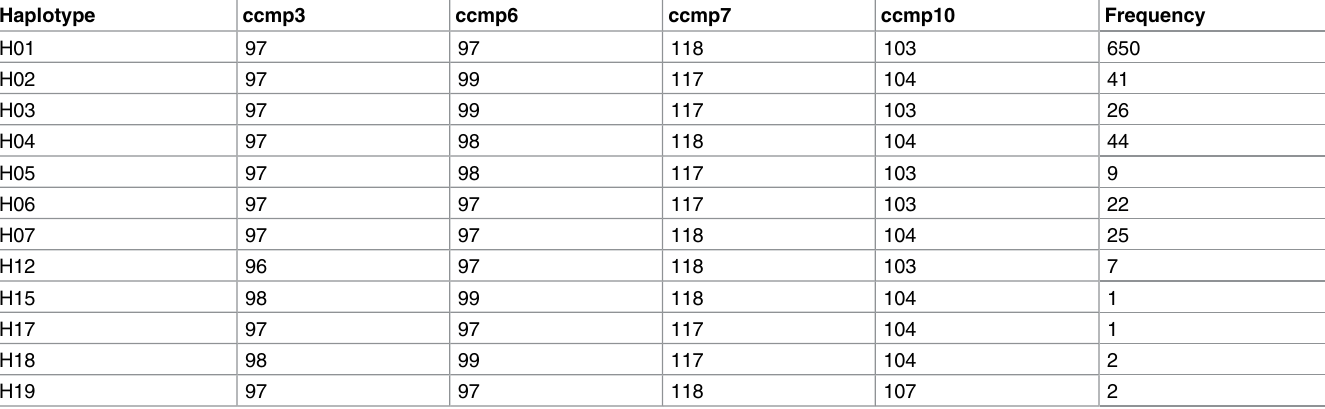
Table 1. Characteristics of the plastid DNA haplotypes detected for Fraxinus excelsior in this study using four chloroplast microsatellite regions. The haplotypedefinitionsfollow Heuertz et al . [41] and Sutherland et al . [33], except for the novel haplotypes H17, H18 and H19. Allele sizes for each of the loci (ccmp3, ccmp6, ccmp7 and ccmp10) are given in base